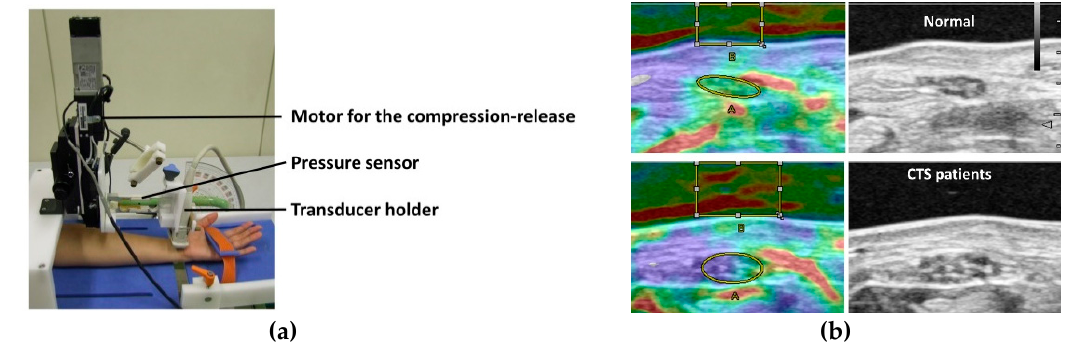
Figure 4. Pressure-monitor ultrasound system for the quantitative assessment of median nerve strain. ( a ) Pressure-monitor ultrasound system, ( b ) elastographic images of CTS patients and normal controls. Upper row shows the image of a normal subject. Lower row shows the image of a CTS patient.